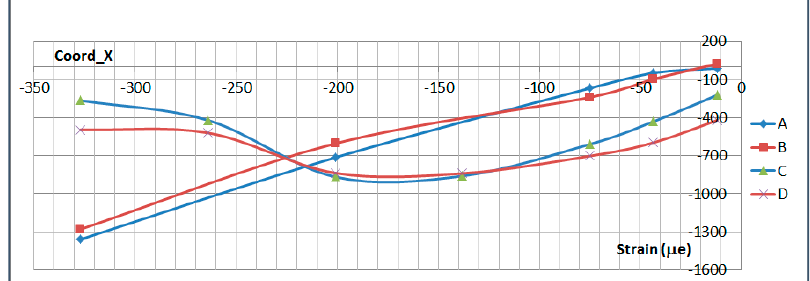
Figure 22. Strain Data along OF in Compression ( − 300 kN).